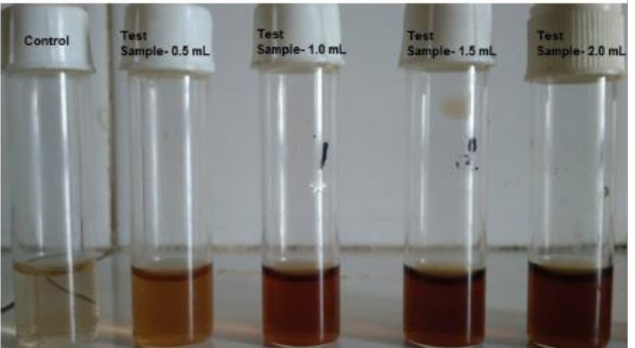
Figure 1. An example of the use of Streptomyces -mediated gold nanoparticles for the detection of phenols from industrial wastewater. (Reprinted from [23] under an Open Access condition).